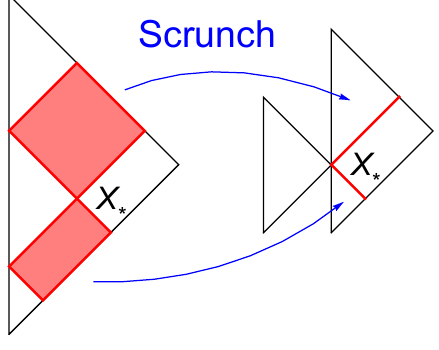
Figure 10 . Factorization of a right triangle domain for the wave equation into smaller